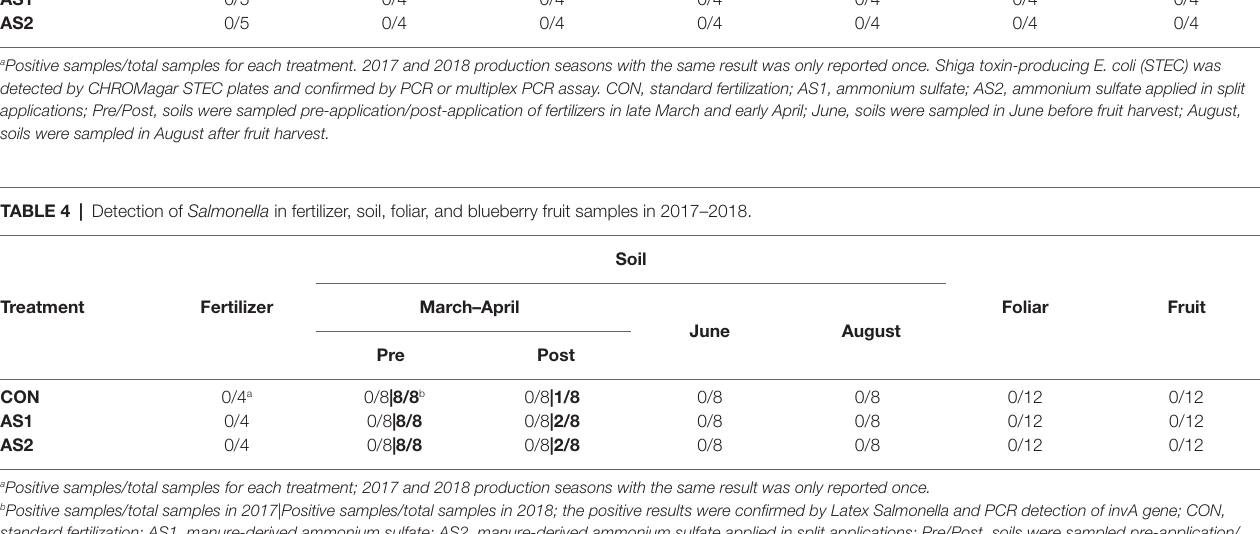
TABLE 3 | STEC analyses in fertilizer, soil, foliar, and blueberry fruit samples in 2017–2018. Treatment Fertilizer